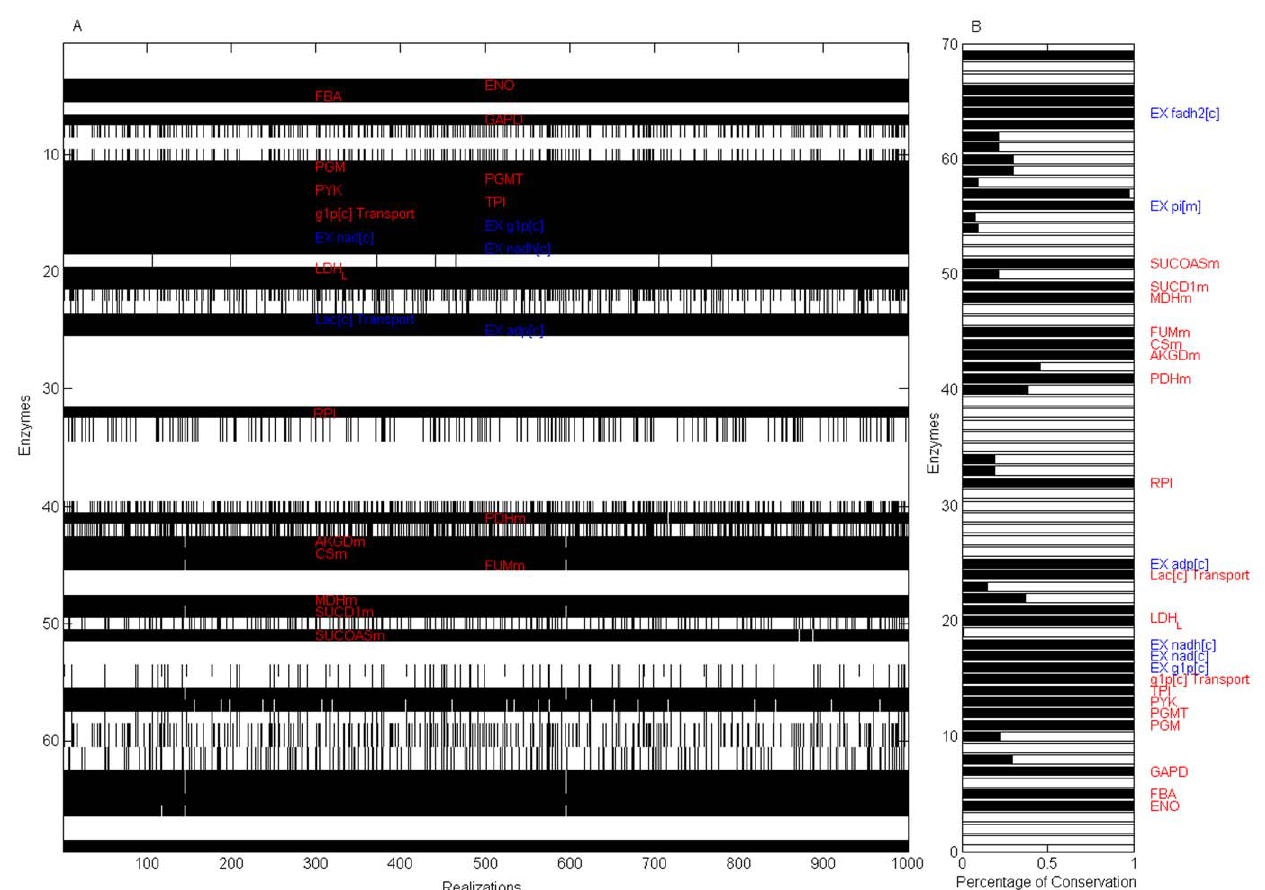
Figure 4. Enzymes with high essentiality and low variability that are robust to the ratio of objective function’s components. Reactions with high essentiality and low variability were identified through a set of 1000 objective functions with nonequivalent ratios among function components. As panel (A) shows, reactions obeying both criteria (red on black regions) were plotted over the 1000 realizations. In each realization, those enzymes that obey the in silico criteria were denoted in black; all others in white. The percentage of times reactions obeyed the computational criteria are depicted in panel (B). Robust enzymes relevant to this study (excluding transporters, exchange and demand reactions) were labeled in red. EX, DM and Sink denote exchange, demand and sink reactions in the cytoplasm [c] and mitochondria [m] compartments.